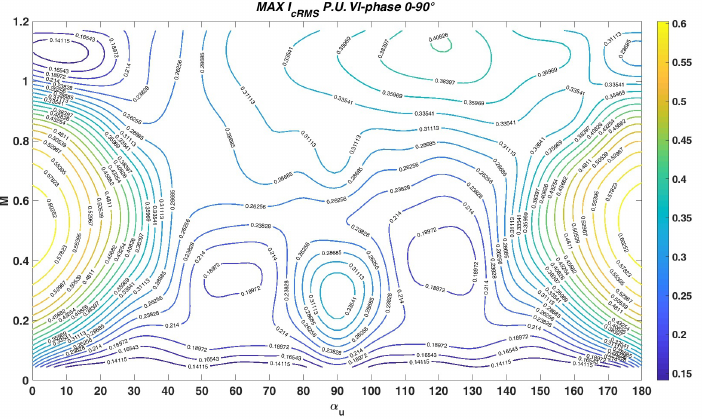
Figure 11. Simulated results: isolevel of greatest I C current worst case vs. α u for all M value. The different figure represents the locus of the greatest I C values for a specific operating range.